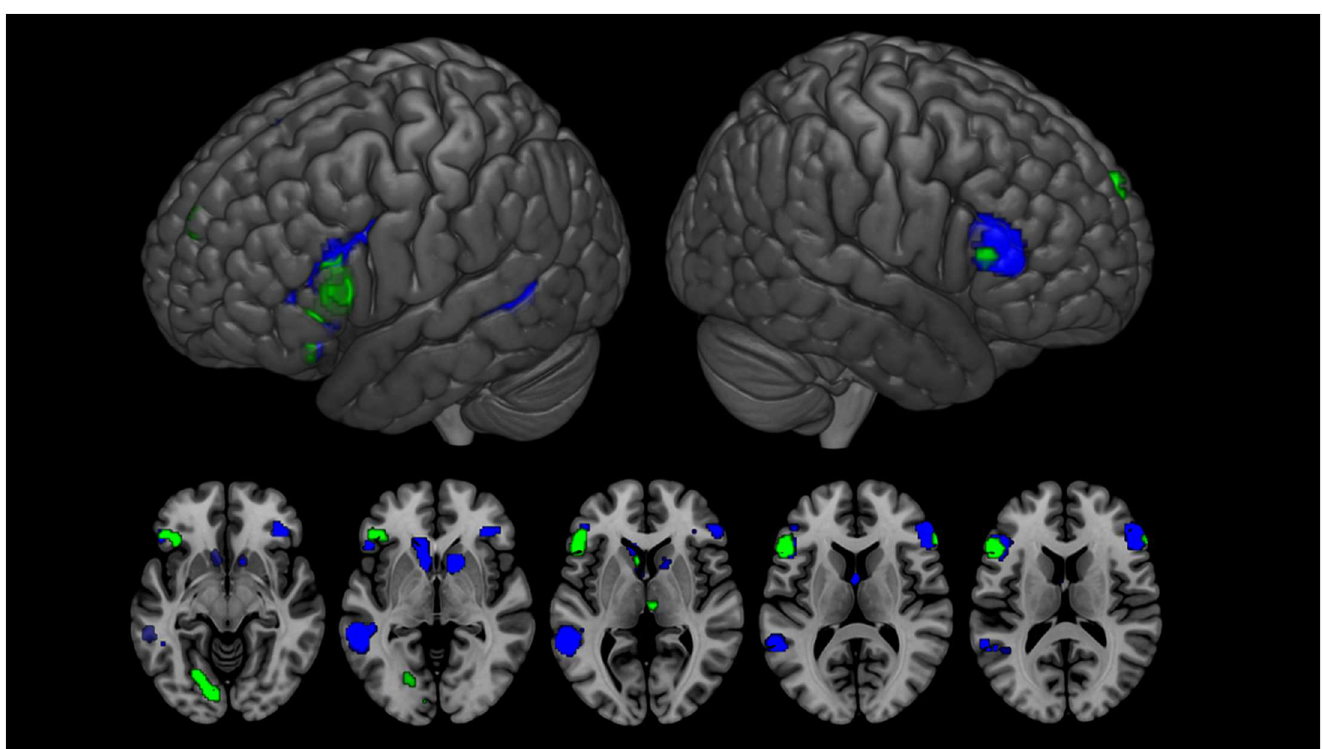
Fig 3. Activation for the Contrast (blue) and Humor (green) effects. p < 0.001 uncorrected, k = 20 voxels. Commonactivationswere localizedin the bilateralinferior frontal gyrus and left caudate.